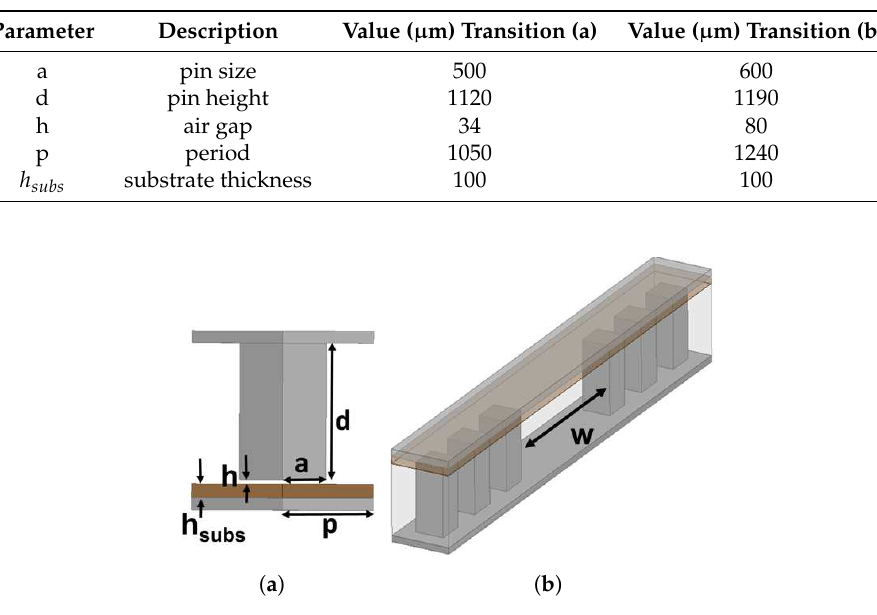
Figure 2. Perspective view of unit cells of: ( a ) metallic pin and ( b ) groove gap waveguide partially filled with Rogers CuClad